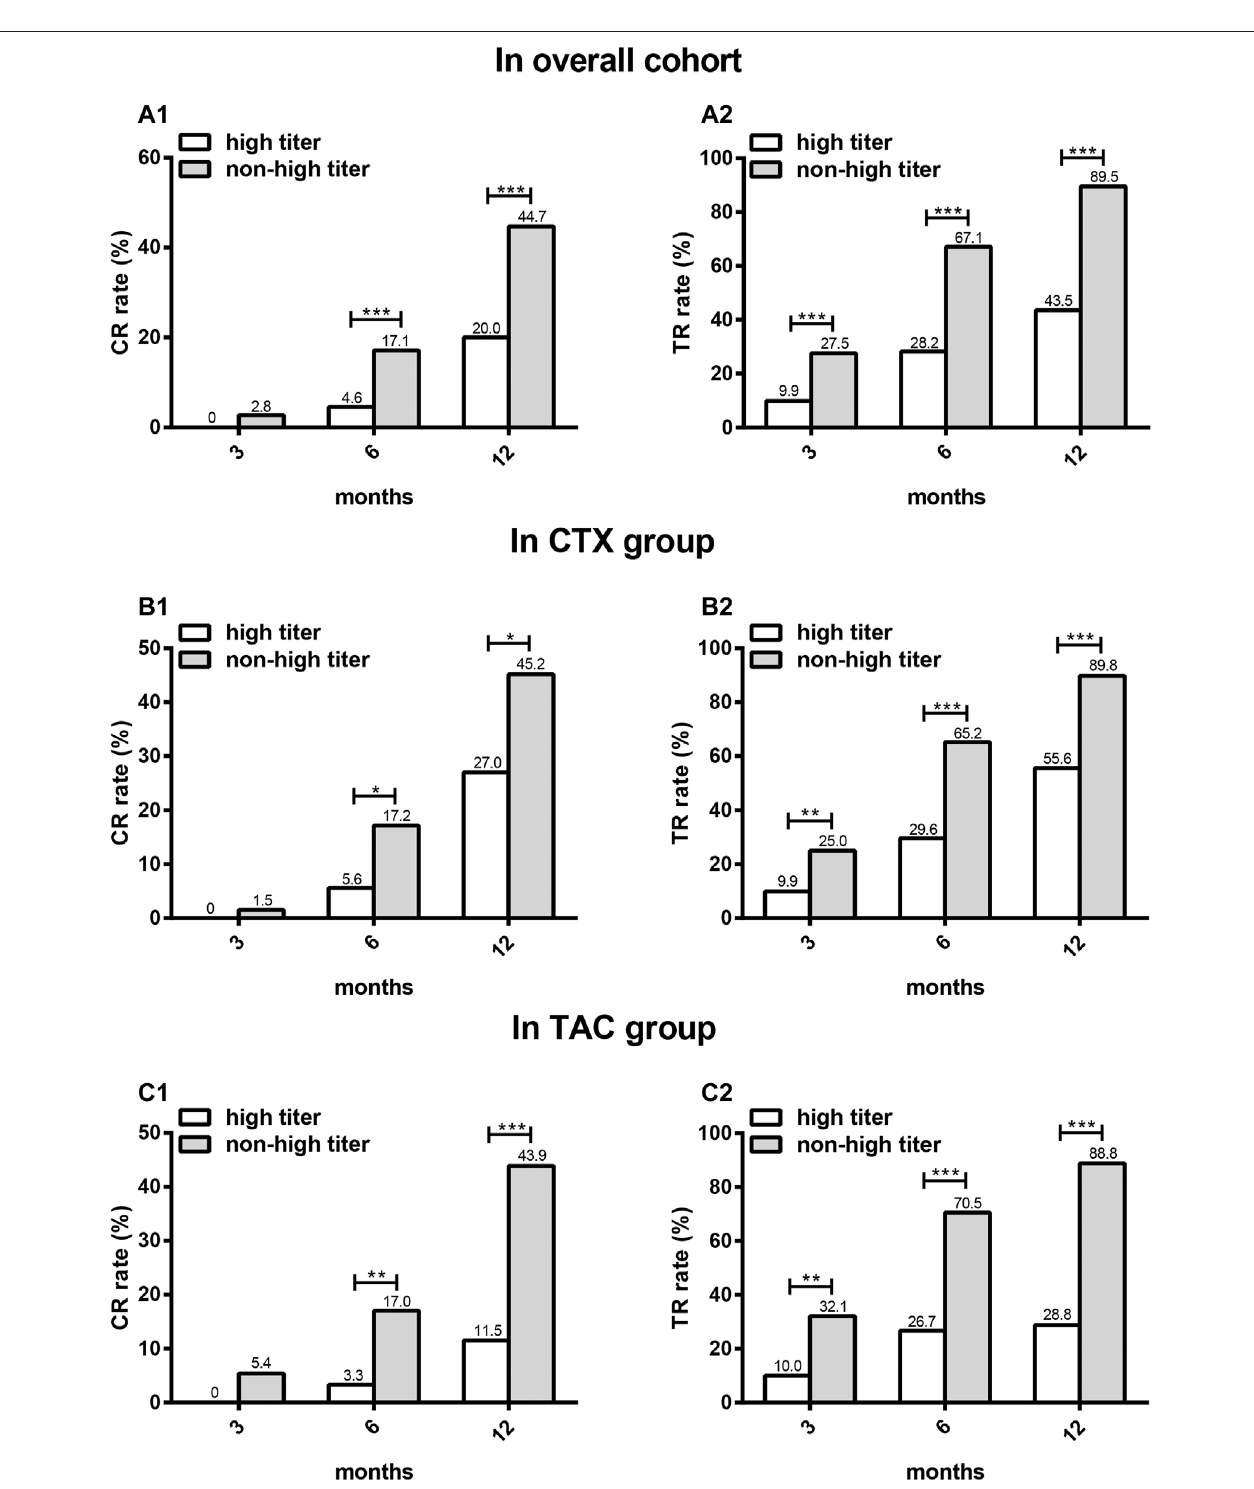
FIGURE3| Thecomparison ofCRandTRratesbetweenhightitergroupandnon-hightitergroupatdifferenttimepointsindifferentpatients.CR (A1) andTR (A2) in overall cohort, CR (B1) and TR (B2) in CTX group, CR (C1) and TR (C2) in TAC group. CR: complete remission; TR: total remission; CTX: cyclophosphamide; TAC: tacrolimus. * p < 0.05, ** p < 0.01, *** p < 0.001.